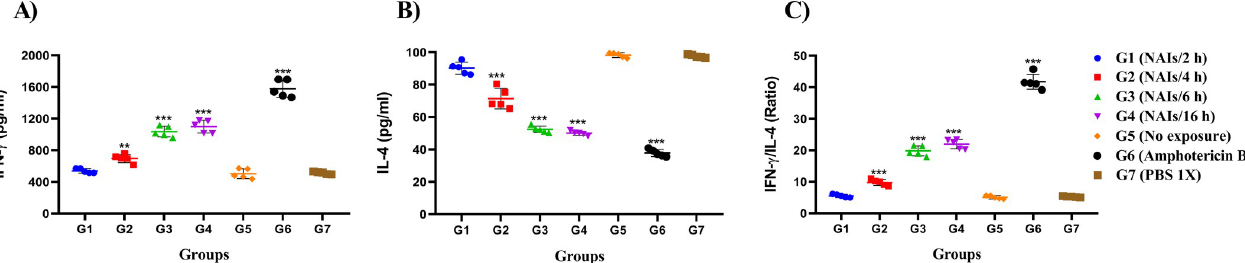
Fig 5. Evaluation of IFN- γ (A) and IL-4 (B) production in the supernatant of stimulated splenocytes of L . major -infected BALB/c mice in NAIs therapy groups (G1-G4) and controls (G5, G6 and G7), and IFN- γ /IL-4 ratio (C) (after the end of treatment, five mice from each group were randomly selected). All data are presented as the mean ± SD, five mice per group. The data show the results of one out of three independent experiments presenting similar outcomes ( � P < 0.05, �� P < 0.01, ��� P < 0.001).